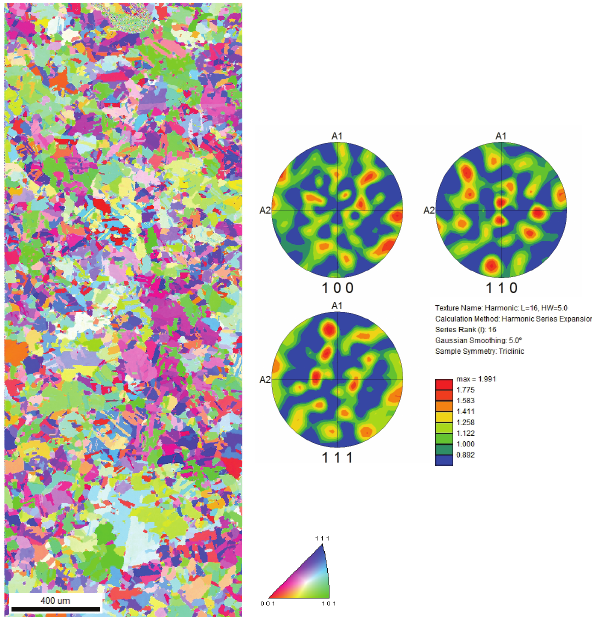
Figure 2. Microstructure of Cu after Helium implantation, characterized using Electron Back Scatter Diffraction along with the texture plot. This shows that the grain size and texture of copper were not altered due to the implantation process.